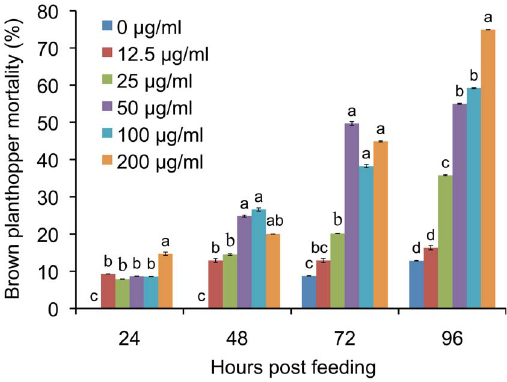
Figure 2. Gramine toxicity to brown planthoppers (BPHs). BPHs were fed on artificial liquid diets containing the indicated concentra- tions of gramine. At 24, 48, 72 and 96 hrs post feeding (h.p.f.), the BPH mortality was determined. Data represent the means 6 SD from three independent experiments with triplicate glass tubes (at least 10 nymphs in each tube) examined for each treatment. Different letters on the bars indicate significance at P , 0.05.